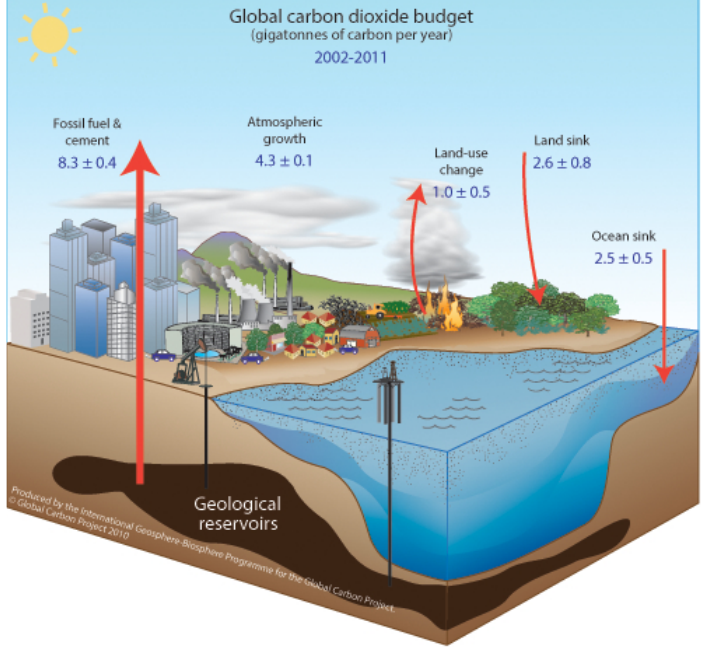
Figure 1. Schematic representation of the overall perturbation of the global carbon cycle caused by anthropogenic activities, averaged glob- ally for the decade 2002–2011. The arrows represent emission from fossil fuel burning and cement production; emissions from deforestation and other land-use change; and the carbon sinks from the atmosphere to the ocean and land reservoirs. The annual growth of carbon diox- ide in the atmosphere is also shown. All fluxes are in units of PgCyr − 1 , with uncertainties reported as ± 1 sigma (68% confidence that the real value lies within the given interval) as described in the text. This Figure is an update of one prepared by the International Geosphere Biosphere Programme for the GCP, first presented in Le Qu´er´e